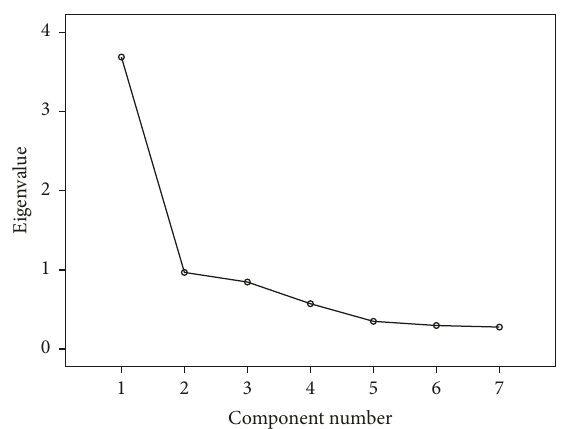
Figure 5: Scree plot for intention domain: construct validity.